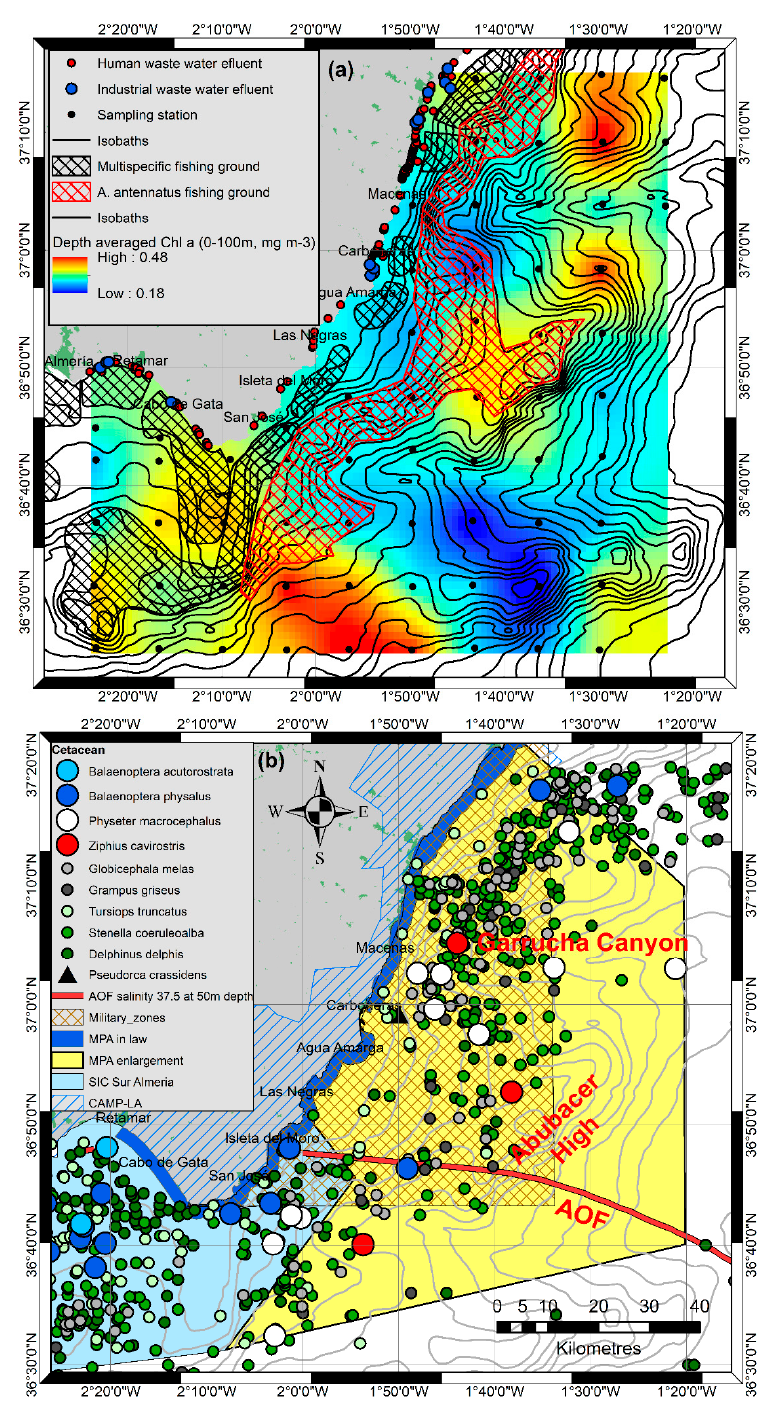
Figure 9. ( a ) Depth-averaged (0–100 m) chlorophyll a concentration (mg · m − 3 ), sites of human and industrial effluents [89], and fishing grounds [76,90]. ( b ) Coastal Area Management Program Levante Almeriense (CAMP-LA), existing Marine Protected Areas (MPAs), and proposed enlargement of the MPA. Presence of cetacean species ( Balaenoptera acutorostrata (minke whale), Balaenoptera physalus (fin whale), Physeter microcephalus (sperm whale), Ziphius cavirostris (Cuvier’s beaked whale), Globicephala melas (long-finned pilot whale), Grampus griseus (Risso’s dolphin), Tursiops truncatus (common bottlenose dolphin), Stenella coeruleoalba (striped dolphin), Delphinus delphis (short-beaked common dolphin), and Pseudorca crassidens (false killer whale)